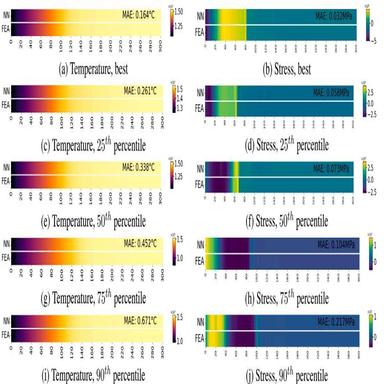
Comparison of MAE for temperature and stress predictions using S-DeepONet and GRU model.